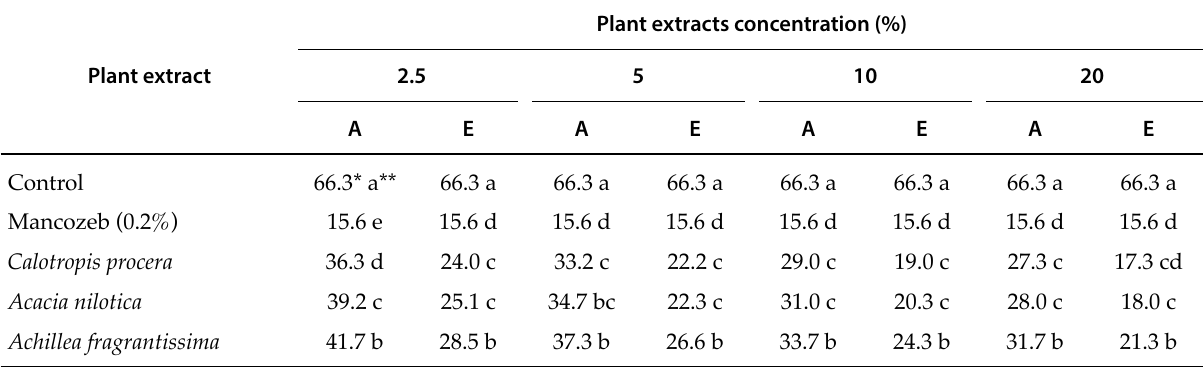
Table 1. Mean linear mycelial growth (mm) of Alternatia solani after 7 d incubation at 25°C, when exposed to aqueous (A) or ethanol (E) extracts from three medicinal plants at different concentrations